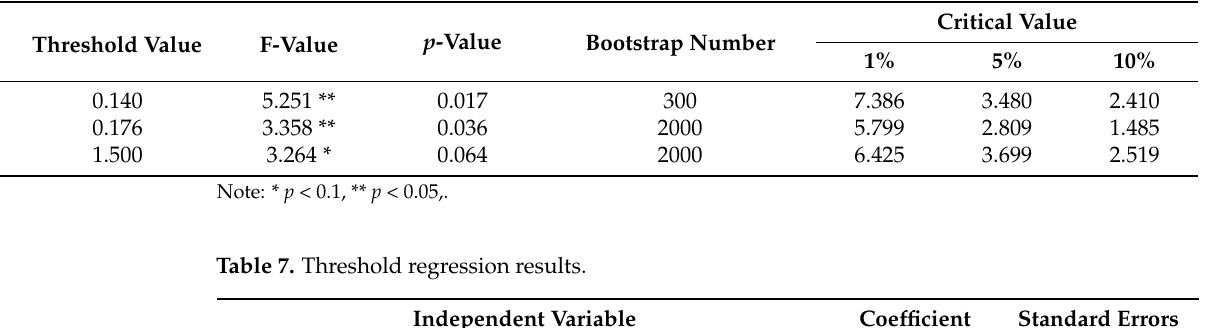
Table 6. Threshold mechanism test.